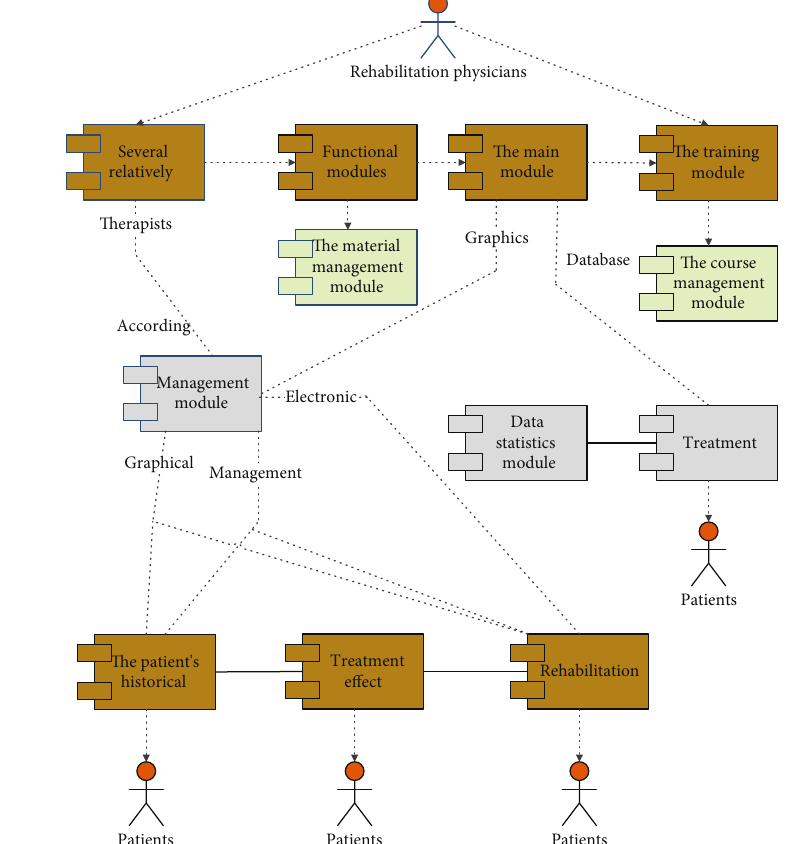
Figure 3: Block diagram of system